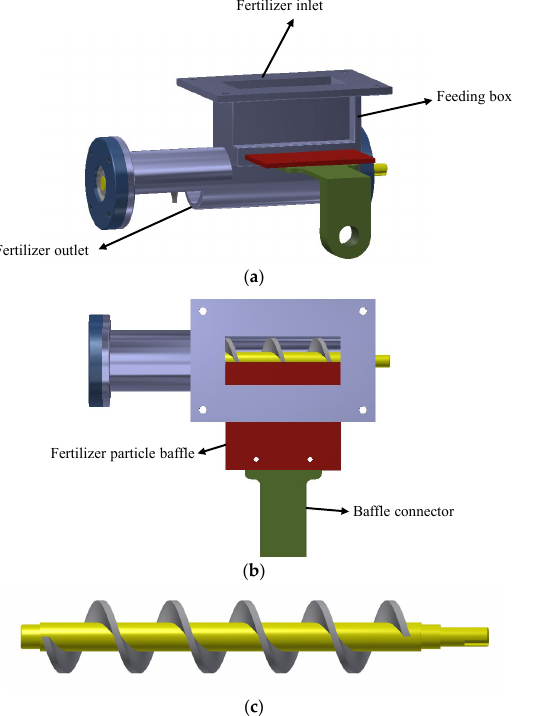
Figure 1. Structure of the granular fertilizer distributor: ( a ) front view of the fertilizer distributor; ( b ) top view of the fertilizer distributor; ( c ) screw conveyor.